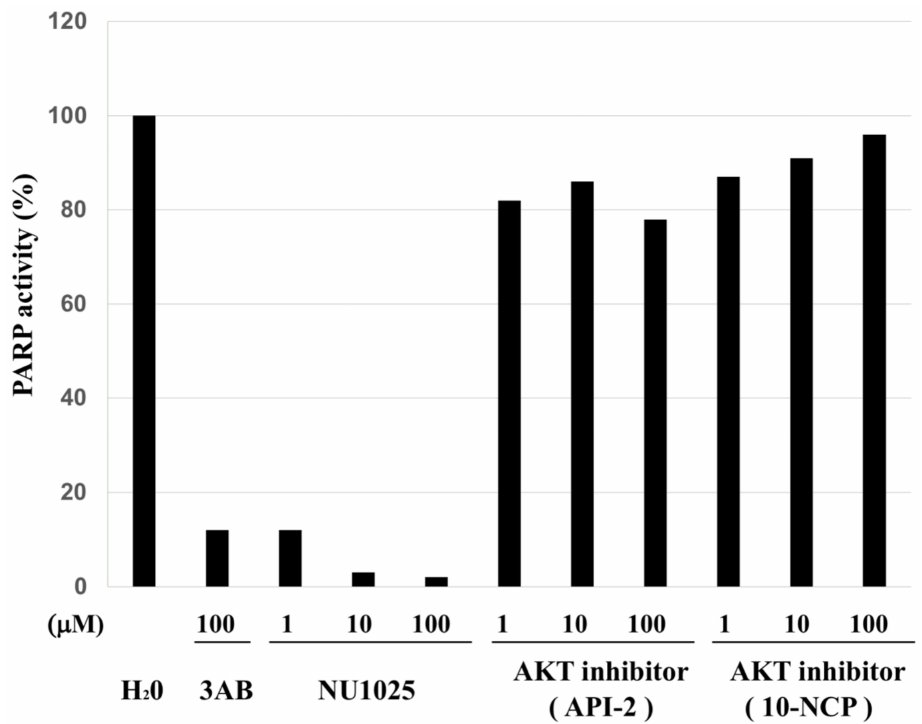
Figure 7. Akt inhibitors did not inhibit PARP1 enzyme activity. Relative PARP1 activity was de- termined in the presence of defined concentrations of 3AB, API-2 and 10-NCP. H 2 O was used as a negative